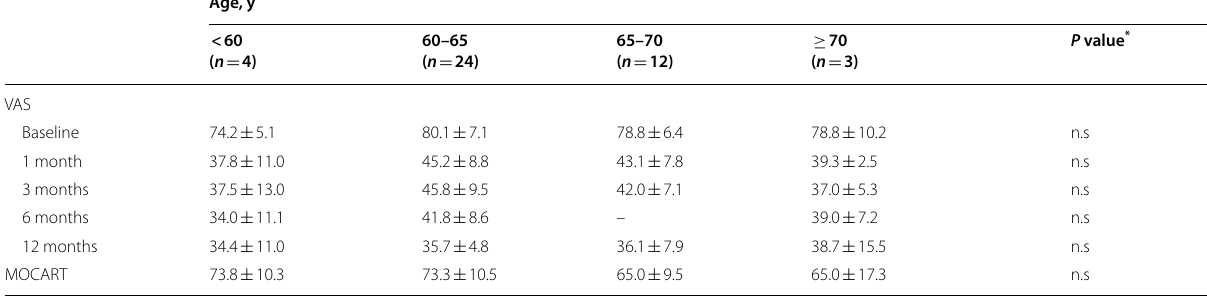
Data are presented as means standard deviation ± MOCART Magnetic resonance observation of cartilage repair tissue, VAS Visual analogue scale * Kruskal–Wallis test